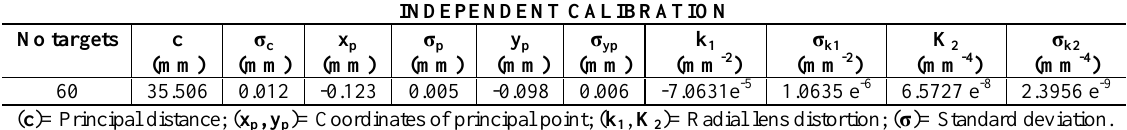
Table 2. The interior orientation parameters (IOP) computed in the “independent calibration that were significant on the variance- covariance matrix.